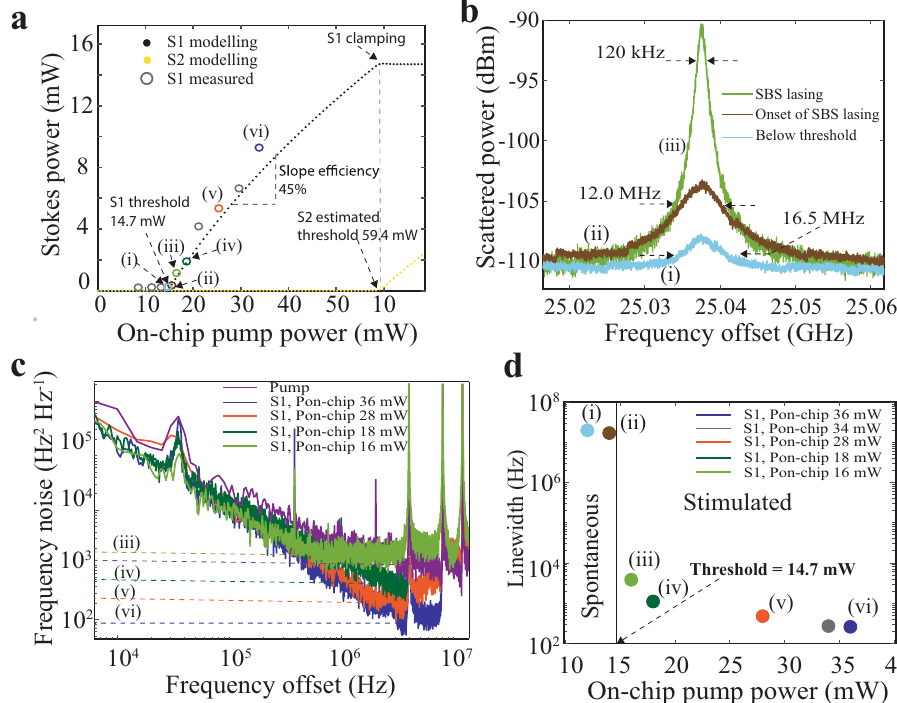
Fig. 4 Stimulated Brillouin scattering (SBS) Stokes threshold, power and linewidth measurements. a Pump optical on-chip power (P on-chip ) vs. fi rst order Stokes (S1) signal power. Measured S1 laser threshold of 14.7 mW, corresponding to a threshold density of 4.92 mW μ m − 2 , and a 45% slope ef fi ciency. Modelling of the S1 optical power (black dots) accurately predicts the measured S1 optical power as the pump power is increased from below to above threshold. The predicted second order Stokes (S2) threshold is ~60 mW (yellow dots). b Measurement of S1 emission linewidth plotted on a logarithmic scale, below threshold (blue trace), just below threshold (brown trace) and just after threshold (green trace). The Brillouin emission linewidth evolves from a spontaneous dominated linewidth of 16.5 MHz, which is approximately the SBS gain fi ltered by the cold-cavity resonator linewidth ~16 MHz, to the onset of stimulated Brillouin, measuring a 12 MHz linewidth just below threshold, to a stimulated dominant 120 kHz linewidth just above threshold. The resolution bandwidth (RBW) of electrical spectrum analyzer (ESA) was set at 1 kHz. c Frequency noise measurements of S1 using a radio frequency (RF) calibrated fi ber optic Mach – Zehnder interferometer (MZI) frequency discriminator. The S1 emission fundamental linewidth for each pump input condition shown in ( c ) is indicated by the corresponding horizontal dotted line. The free-running pump frequency noise (purple trace) is for an unlocked pump (i.e., not locked to the stable cavity or SBS resonator). As the pump is increased, a decrease in fundamental linewidth (curves ii – v) is measured. Since the back re fl ected pump is not optically fi ltered before frequency noise discrimination, there is a pump noise contribution to the measured frequency noise of S1. Just above threshold, the conversion from pump to S1 is low, and the white noise fl oor at 16 mW pump (green) is a combination of pump, S1 and their beat note. As the on-chip pump power (P on-chip ) is increased, the intra-cavity S1 photon number increases while the pump signal is depleted and decreases to below 10 dB of the Stokes for all other FN traces. d Summary of beat note and fundamental linewidths from ( b ) to ( c